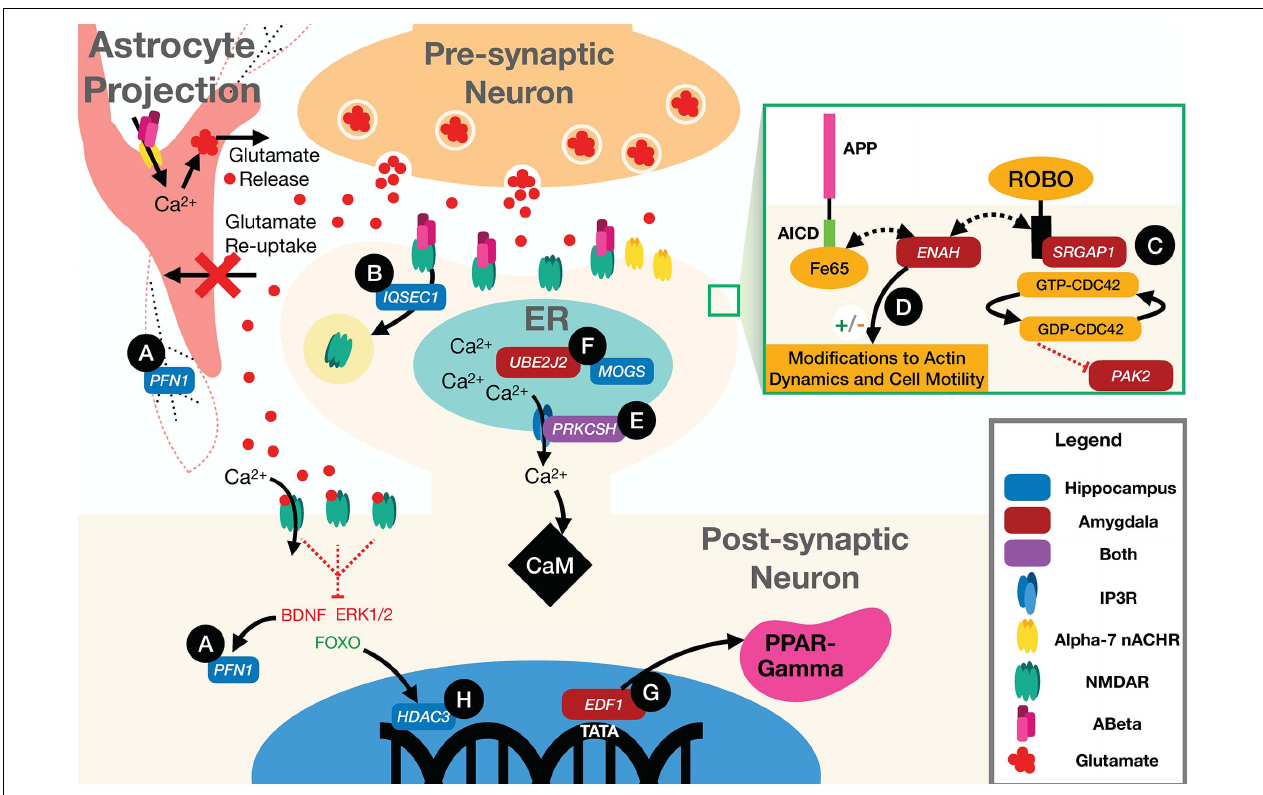
FIGURE 6 | Illustration of neuronal and astrocytic pathways implicated in the disease according to the top scoring genes according to our integrated ranking. (A) Loss of signal from BDNF to PFN1 downregulates the activity of the gene, impairing F-actin structure in the neuron and astrocyte. (B) IQSEC1 mediates AMPAR and NMDAR receptor internalization. (C) PAK2 activity is partially regulated by the CDC42 GTPase which is activated by binding of the SLIT protein to ROBO at the membrane. This activity can be interrupted by the activity of SRGAP1 which inhibits ROBO signaling. (D) ENAH can bind to both ROBO and Fe65. When bound to ROBO it acts to inhibit actin polymerization and motility, but while bound to Fe65 and the AICD the ROBO pathway functions normally, promoting cell motility, and actin polymerization. (E) PRKCSH co-localizes with IP3Rs increasing calcium current through the channels, increasing cytosolic levels of Ca 2 + . (F) UBE2J2 and MOGS are both involved in the proper regulation of intra-ER processes. Impairment of the proper activity of post-translational modification by MOGS could drive ERAD mediated by ubiquitination by UBE2J2 . (G) EDF1 is also a transcriptional regulator for PPAR-gamma. Activation of PPAR-gamma helps to regulate disturbed metabolic states and A plaque clearance. (H) HDAC3 regulates transcription of many genes that have an effect on A β burden, microglial activation, and dendritic spine